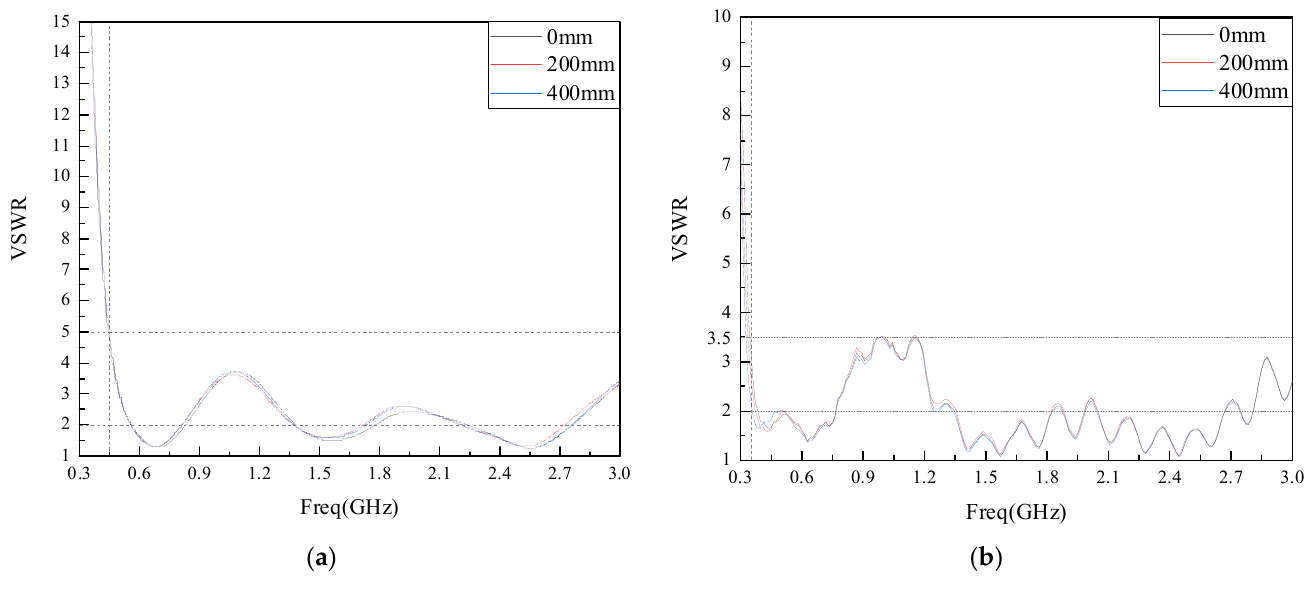
Figure 9. Antenna VSWR under different bending radius: ( a ) Antenna VSWR simulation diagram; ( b ) Antenna VSWR measured diagram.